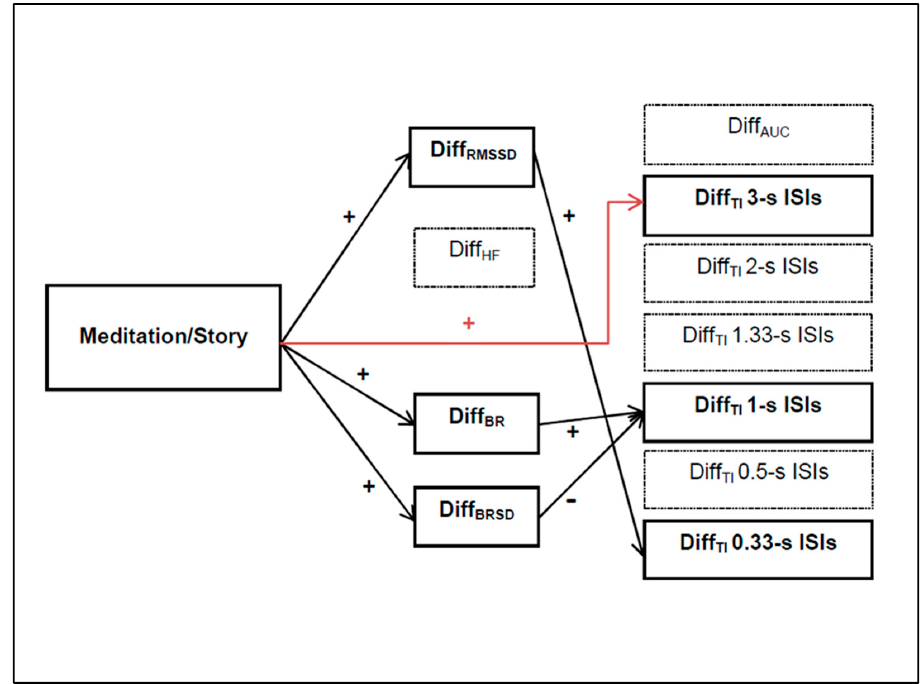
Figure 2. Illustration of the significant X → M relation ( a path) and the significant direct e ff ect ( c ’ path in red color ) and indirect e ff ects ( ab paths) obtained by the mediation analysis with n = 84. The direction of the e ff ects is pictured with + for a positive relation and − for a negative